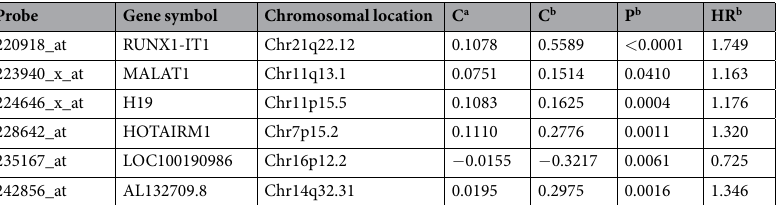
Table 1. Overall information of six prognostic lncRNAs associated with DFS in GSE9891 training cohort (n = 100). a Derived from the LASSO penalized regression in 100 patients of GSE9891 training cohort. b Derived from the univariate Cox proportional hazards regression in 100 patients of GSE9891 training cohort. Abbreviations: C Coefficient, P P value, HR Hazard